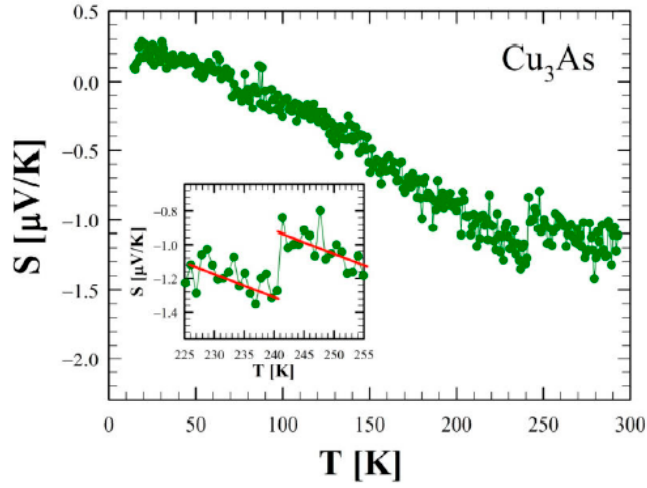
Figure 15. Seebeck coefficient as a function of temperature between 2 and 300 K for Cu 3 As. The inset, which shows a magnification of the data between 225 and 255 K, highlights the discontinuity at about 242 K.